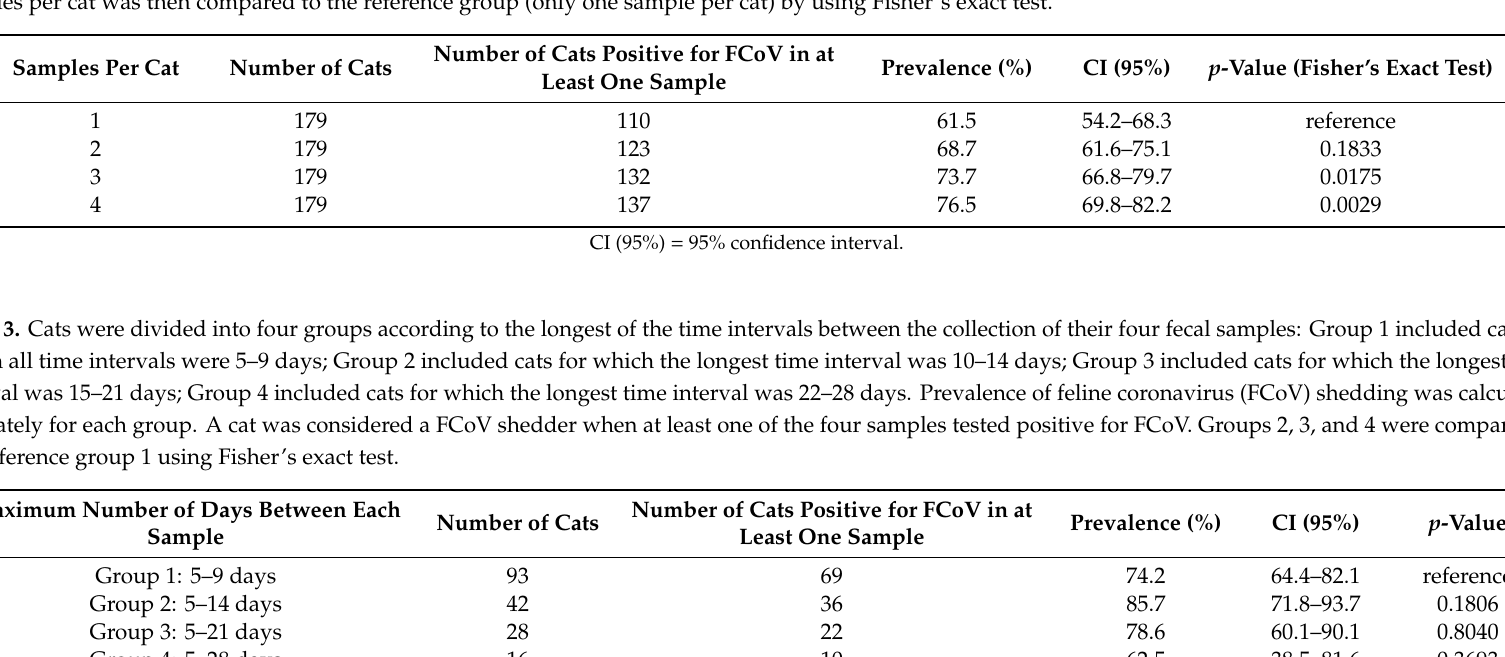
Table 2. Prevalence of feline coronavirus (FCoV) shedding for each cat was calculated separately by considering only the last collected sample (one sample per cat), the last two collected samples (two samples per cat), the last three collected samples (three samples per cat), and all four samples. Prevalence for two, three, and four samples per cat was then compared to the reference group (only one sample per cat) by using Fisher’s exact test.